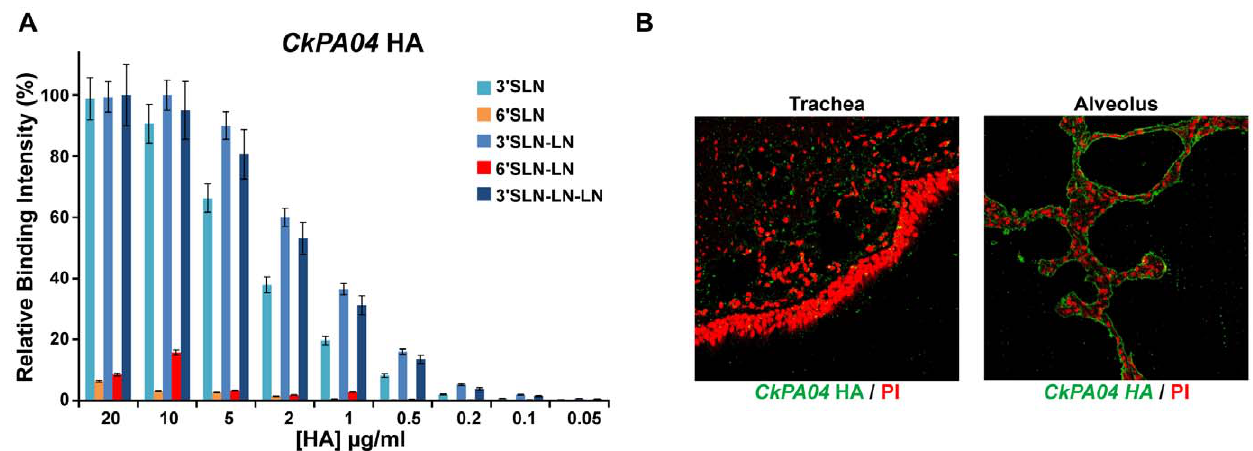
Figure 3. Glycan receptor-binding specificity of CkPA04 HA. A , shows dose-dependent direct glycan array binding of CkPA04 HA which shows high affinity binding to avian receptors in comparison with human receptors. B , shows extensive alveolar staining and minimal staining of apical surface of the human tracheal epithelia by CkPA04 HA (in green ) shown against propidium idodide staining (in red ).